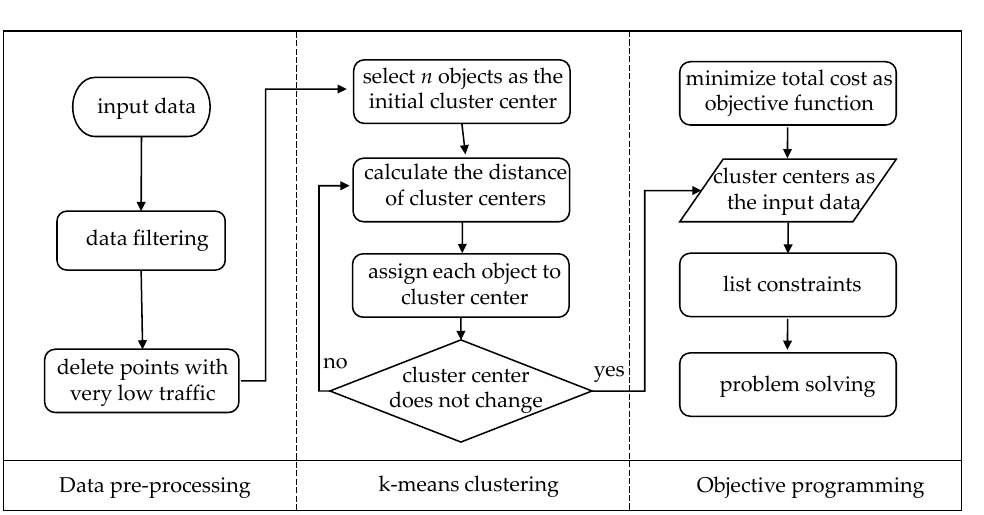
Figure 2. Schematic diagram of 0–1 clustering planning.